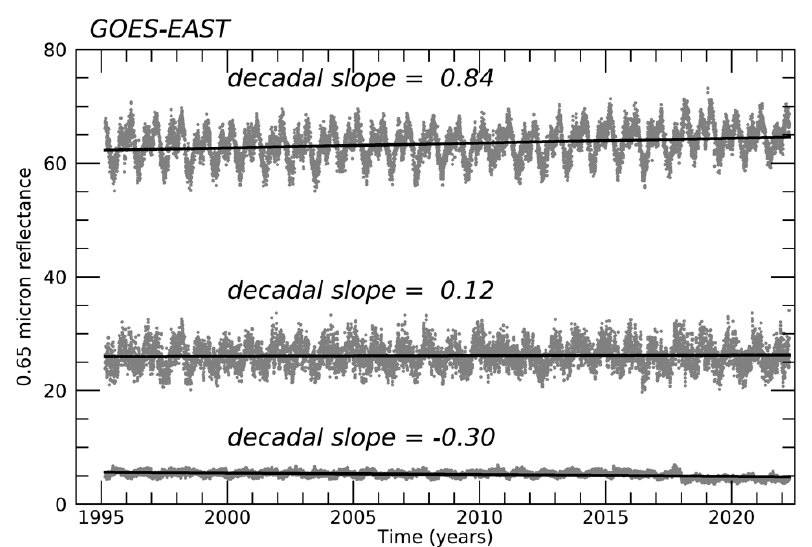
Figure 9. Values of 0.65 micrometer reflectance from each GOES-East full-disk image used in this study. Each series of points shows the values when the cdf curve is 0.05, 0.5, and 0.8. The linear fit to each set of points is shown as the solid lines, and the decadal slope is shown above. The units of slope are reflectance units (%) per decade.